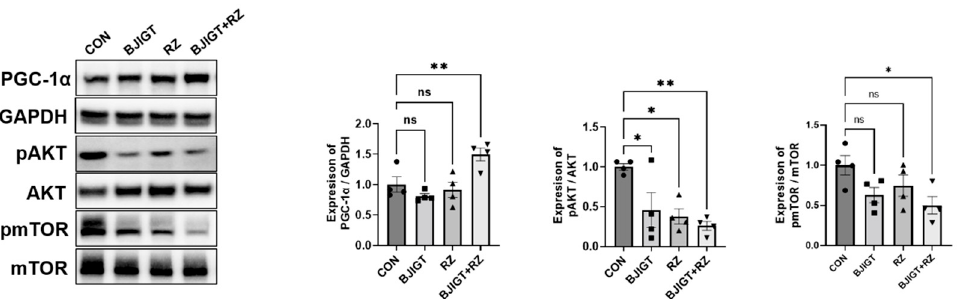
Figure 2. Combined BJIGT/RZ treatment ameliorates metabolism dysfunction in the GC of the hSOD1 G93A ALS mouse model. Representative Western blots depicting the alteration in metabolism- related proteins including peroxisome proliferator-activated receptor gamma coactivator 1-alpha (PGC-1 α ), pAKT, and phosphorylated mammalian target of rapamycin (pmTOR) in the GC of each group of hSOD1 G93A mice. Glyceraldehyde-3-phosphate dehydrogenase (GAPDH) was used as a loading control to normalize the protein levels. Quantification of immune blots; the level of PGC-1 α was normalized to that of GAPDH and the levels of pAKT and pmTOR were normalized to the total AKT and total mTOR levels, respectively; the drug treatment groups were compared with the control group ( n = 4/group). Data are normalized to the control group data and presented as mean ± SEM. ns; not significant, * p < 0.05, ** p < 0.01, compared with the control group. Distilled water (DW)-administered transgenic (Tg) mice (CON), BJIGT-treated Tg mice (BJIGT), RZ-treated Tg mice (RZ), and combined BJIGT/ RZ treated Tg mice (BJIGT+RZ). The different number of circles, squares, and triangles are indicated the number of sample sot.